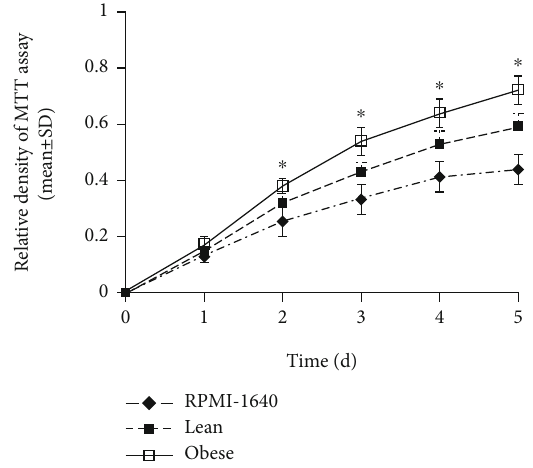
Figure 5: TE-1 cell proliferation in di ff erent states. TE-1 cultured with conditioned medium from sera of obese mice grew faster than those from lean or RPMI-1640. ∗ P < 0 : 05 vs.